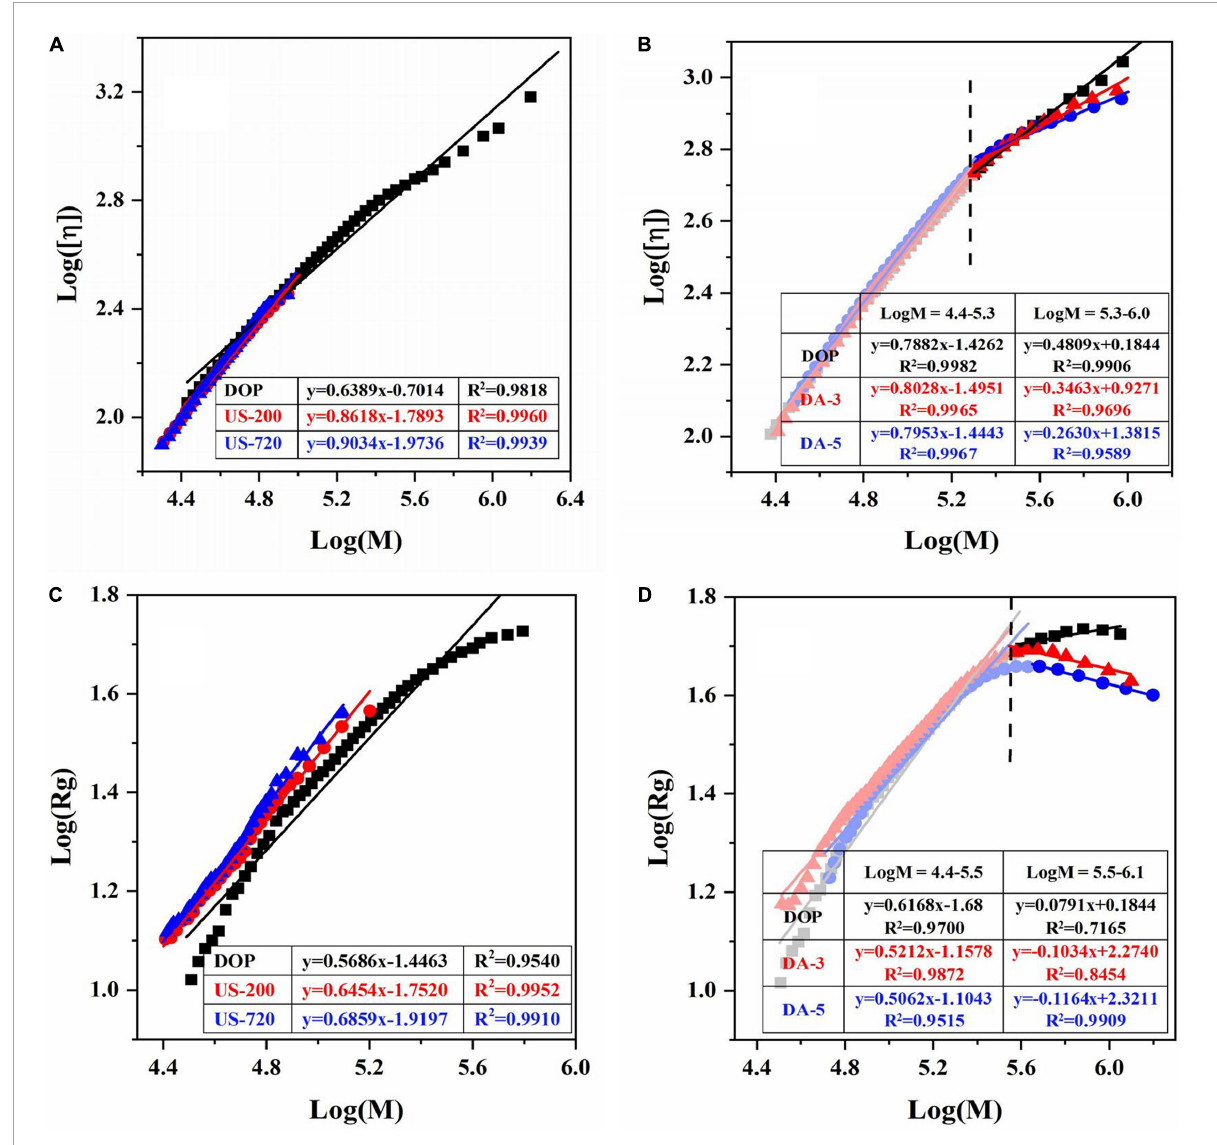
FIGURE2 Logarithmic plot of the molecular weight vs intrinsic viscosity, radius of gyration of native and modified DOPs in aqueous solution. The Mark-Houwink plots of ultrasound (A) and de-acetylated (B) samples. The Rg power-law plots of ultrasonic (C) and de-acetylated (D)